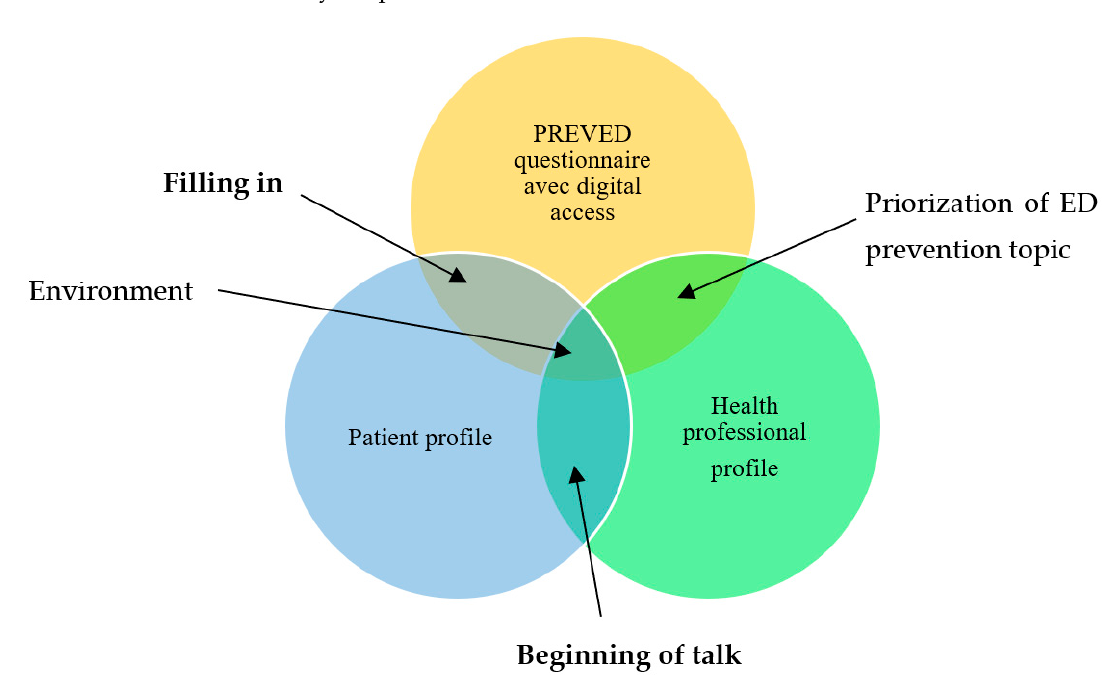
Figure 1. Modalities of MEDPREVED feasibility and accessibility.